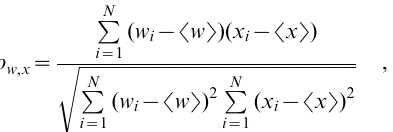
Figure S1 Wealth distribution of Sweden from 1999 to 2006 with fits. Black triangles mark the data, the continuous blue line is a power law fit with exponent as indicated, and the broken blue line is an exponential fit with ‘‘wealth temperature’’ as indicated. Data source: [30]. Figure S2 Comparison between renormalized wealth distribution on day 1200 and on a varying second day.